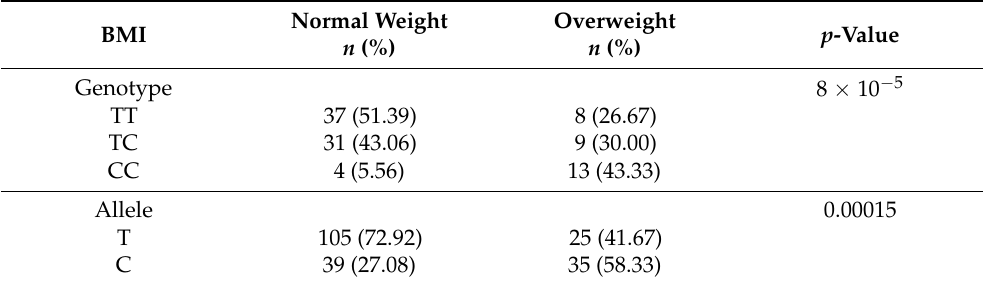
Figure 4. A pairwise comparison subsequent to three-way ANOVA showed, in hyposmic subjects, that females homozygous for the C allele exhibited a higher BMI than subjects that were TT homozygous or heterozygous ( p < 0.005; Fisher’s LSD test), and that males rs2821557 polymorphism of the Kv1.3 gene, sex and TDI olfactory status are shown in who were heterozygous or CC homozygous exhibited a higher BMI than subjects that were homozygous for the T allele ( p < 0.05; Fisher’s LSD test). Instead, no difference was observed between genotype and sex among normosmic individuals ( p > 0.05; Fisher’s LSD